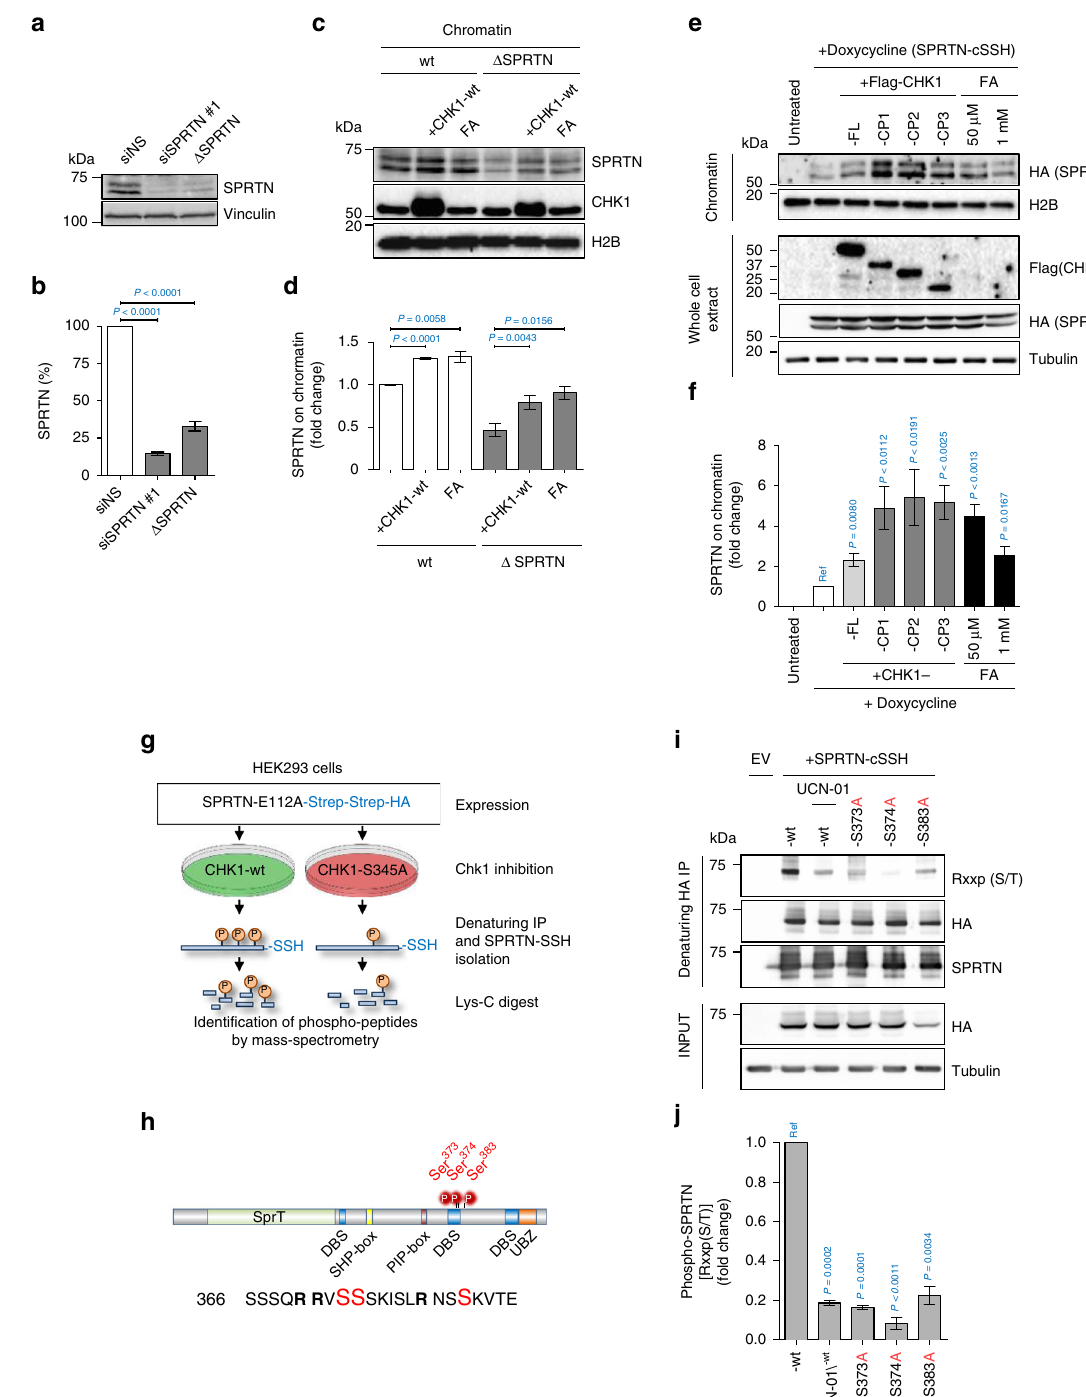
expression of CHK1-wt stimulated SPRTN-SSH accumulation on chromatin. Strikingly, ectopic expression of the N-terminal CHK1 fragments additionally enhanced the SPRTN-SSH recruitment to chromatin (Fig. 6e, f), and also phosphorylated SPRTN much more than full length CHK1 (Supplementary Fig. 5g, h). These results may explain why the ectopic expression of CHK1-wt or its N-terminal fragments restores the phenotypes arising from SPRTN-de fi ciency in human cell lines and zebra fi sh embryos. NATURE COMMUNICATIONS| (2019) 10:3142